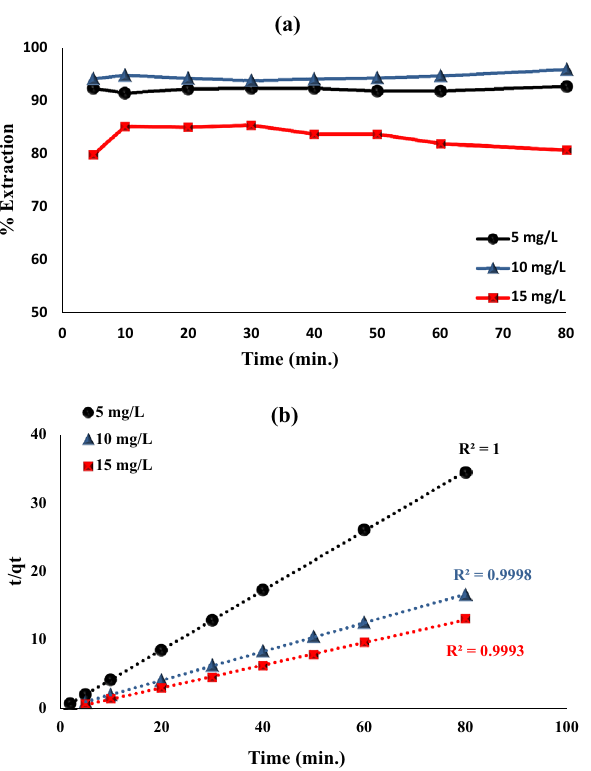
Figure 8. ( a ) Impact of time on Cr(VI) ions removal by Fe 0.75 Cu 0.25 -BDC@Alg-MoO 3 /GO and ( b ) Pseudo - second order model for removal of Cr(VI)